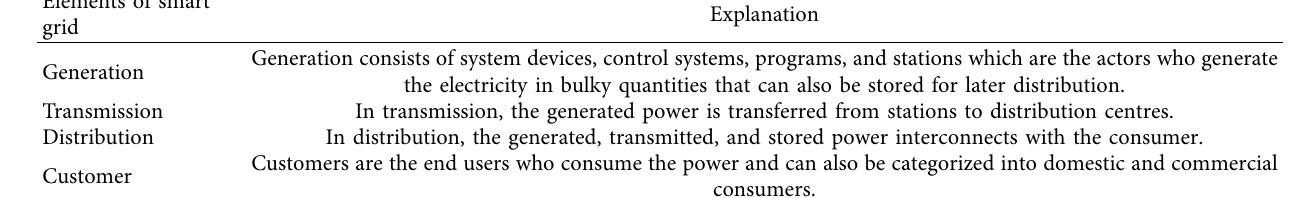
Figure 1: Smart grid main technologies Table 1: Smart grid elements.